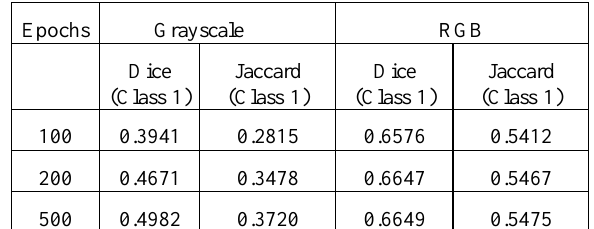
Table 2: Average Dice and Jaccard score for class 1 of the gray and RGB models for 100, 200, and 500 epoch model